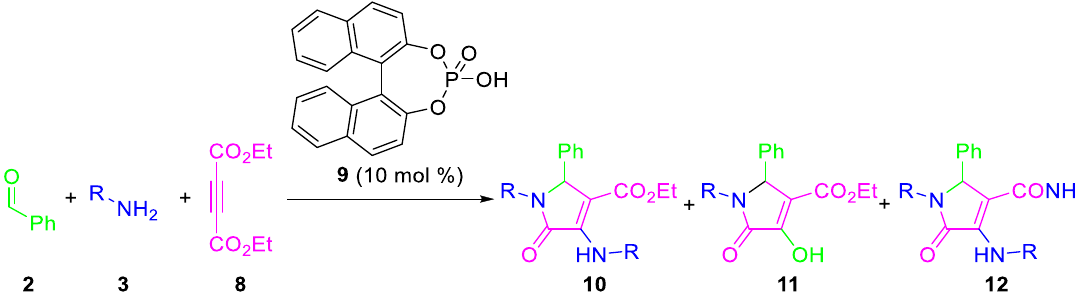
Table 1. Three-component reaction of ethyl pyruvate 1 , benzaldehyde 2 , and amines 3